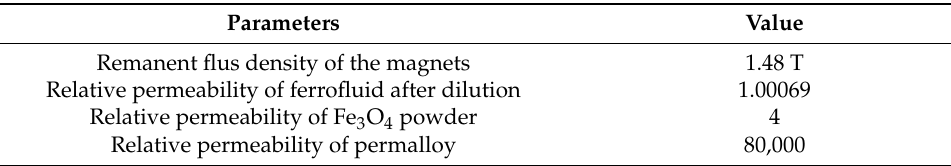
Table 1. The parameters used in the simulations.